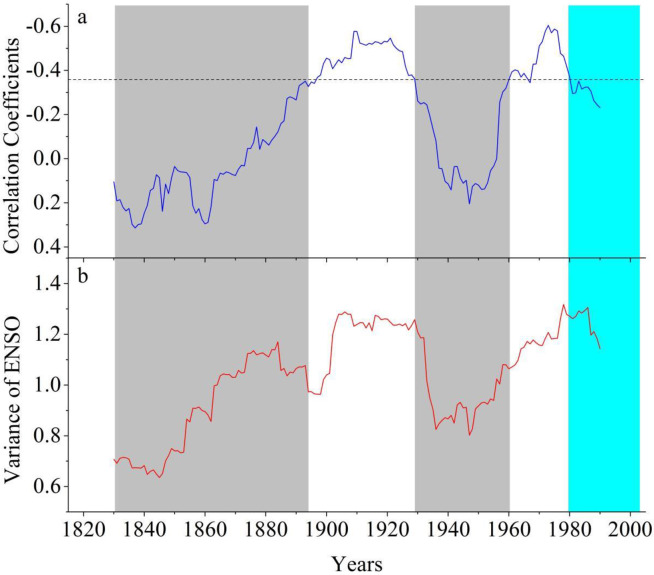
a) The 31-year running correlations (assigned to center year of the window) between the reconstructed EASM and the reconstructed ENSO variability [47] during the common period of 1815–2005. The dashed line symbolizes the 95% confidence level; b) The 31-year running variability of the reconstructed ENSO indices during the period of 1815–2005.